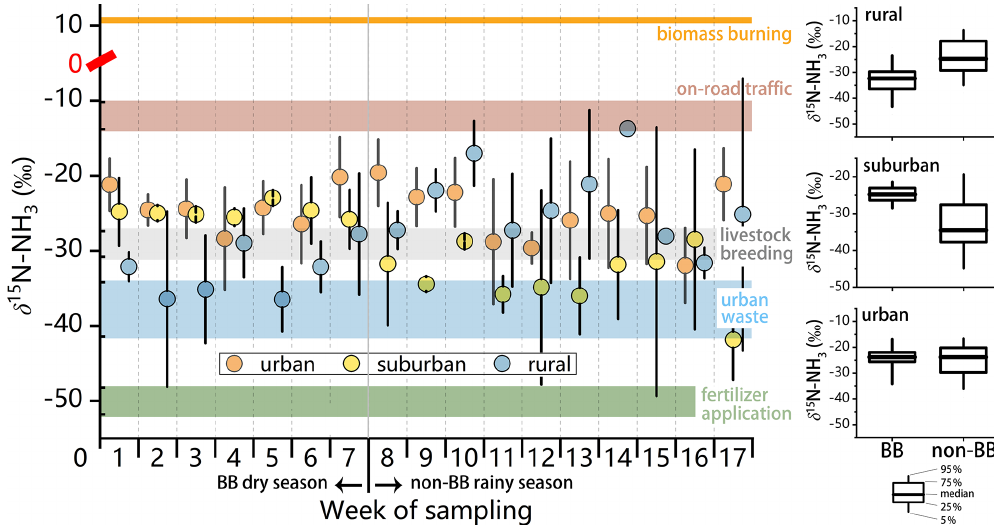
Figure 5. The left panel shows weekly variations in the δ 15 N values (‰) of ambient NH 3 measured in urban, suburban and rural environments (setting 0 as the breaking point). The error bars indicate 2 standard deviations. The right panels present box plots of the distribution of δ 15 N– NH 3 during the BB season and non-BB season for each type of sampling